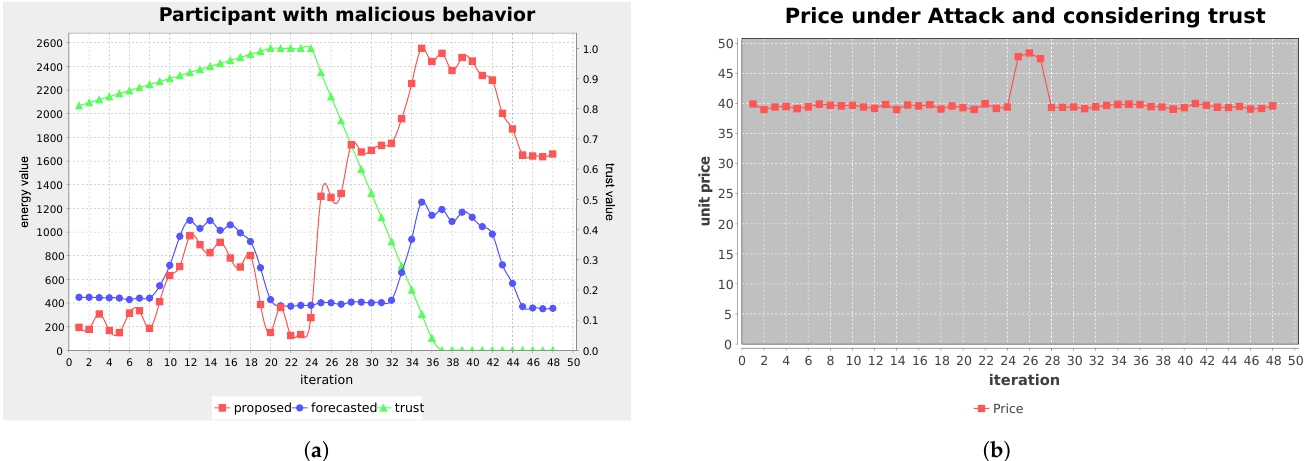
Figure 4. Scenario 3. ( a ) Participant evaluation with attack (considering Trust); ( b ) Agreed price with attack (considering